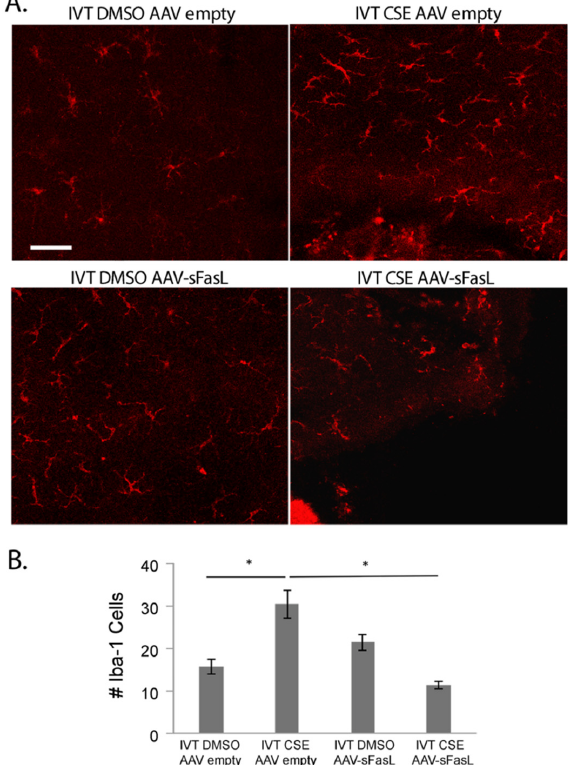
Figure 8. Fas inhibitor gene therapy AAV2-sFasL reduces the inflammatory microenvironment following cigarette smoke extract. Wild-type mice ( n = 5 per group) were given IVT AAV2-sFasL or IVT AAV2-empty vector in each eye. Two weeks later, mice were given IVT CSE in one eye or DMSO vehicle in the contralateral eye. ( A ) After 10 days, retinal flatmounts were immunolabeled for Iba-1 to identify macrophages and microglia. Bar = 50 µ m. ( B ) Graph showing that the number of Iba-1-labeled cells increases with CSE and that AAV2-sFasL decreases the number of Iba-1-labeled cells to control levels in CSE-treated mice. * p <